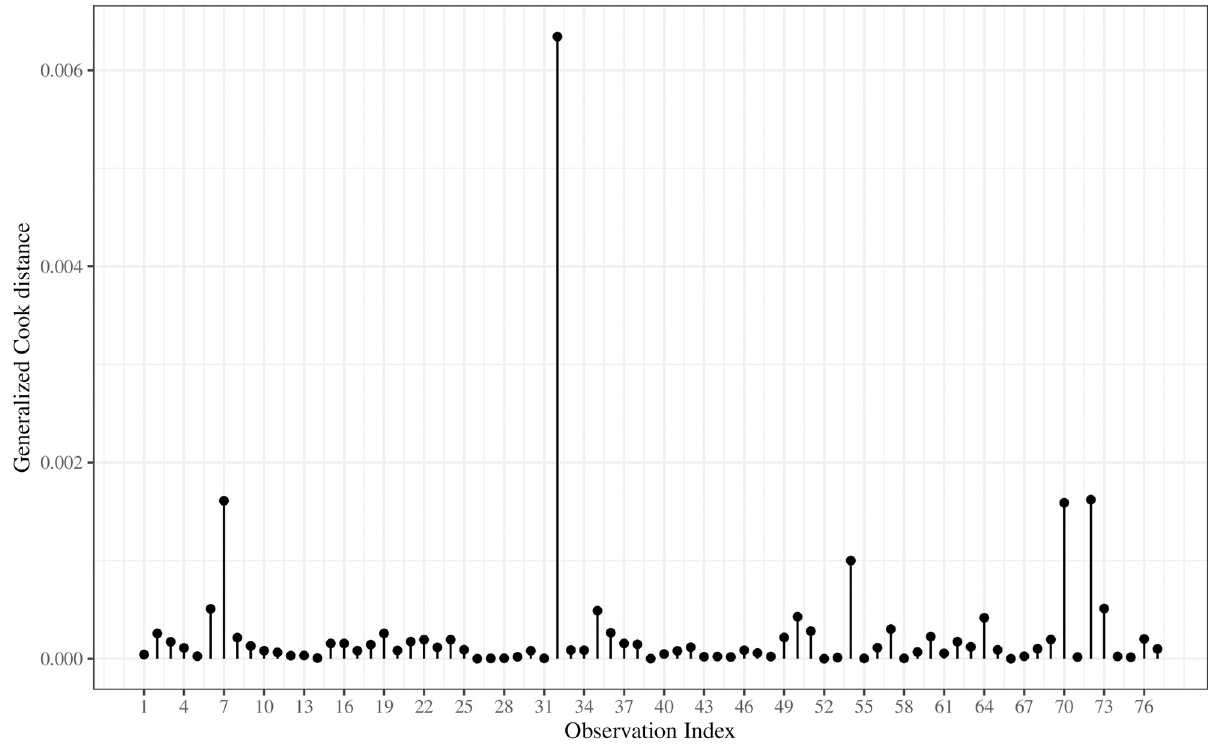
Fig 8. Generalized Cook distance for the UBXII